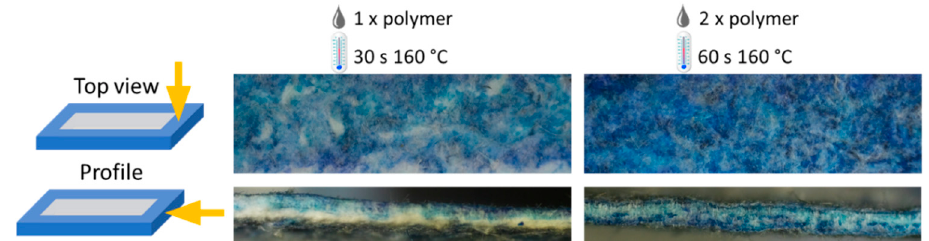
Figure 4. Penetration depth of wax soaked into glass microfiber. Top view and profile of a channel barrier are shown with a single and double amount of wax and 30 or 60 s of heat application to the glass microfiber.